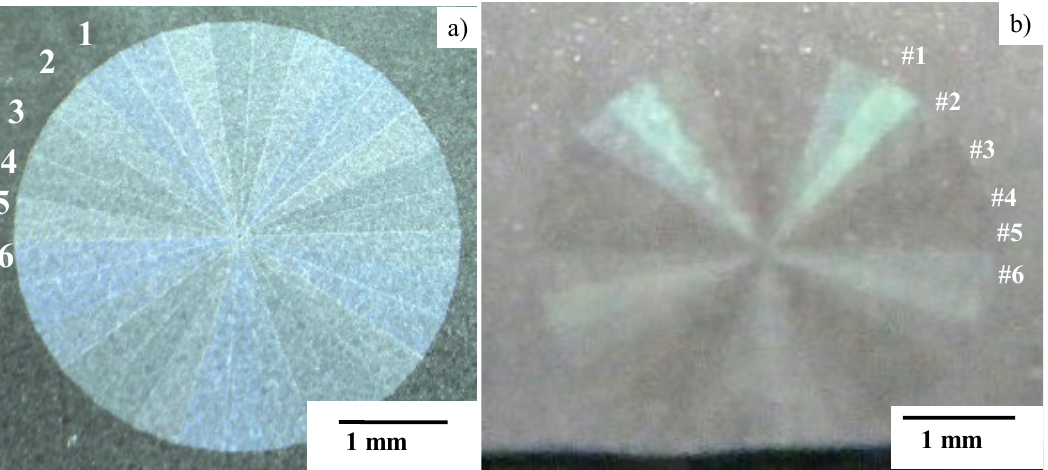
Figure 13. Comparison between the M6 emblem laser-printed onto the AISI316 flat die and the M6-replica, CNC-imprinted onto the AA1060 plate. ( a ) Original M6 emblem on the die, and ( b ) M6-repica on the aluminum plate.